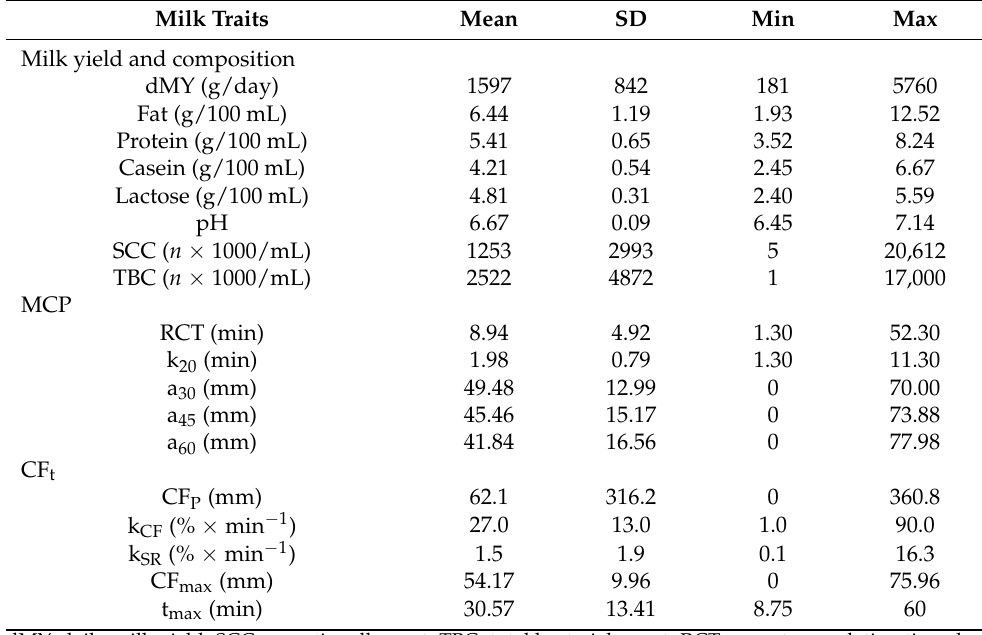
Table 2. Descriptive statistics of the milk yield and composition, milk coagulation properties (MCP), and curd firmness over time traits (CF t ) from the sampled population of Sarda sheep ( n = 1112). Milk Traits Mean SD Min Max Milk yield and composition dMY